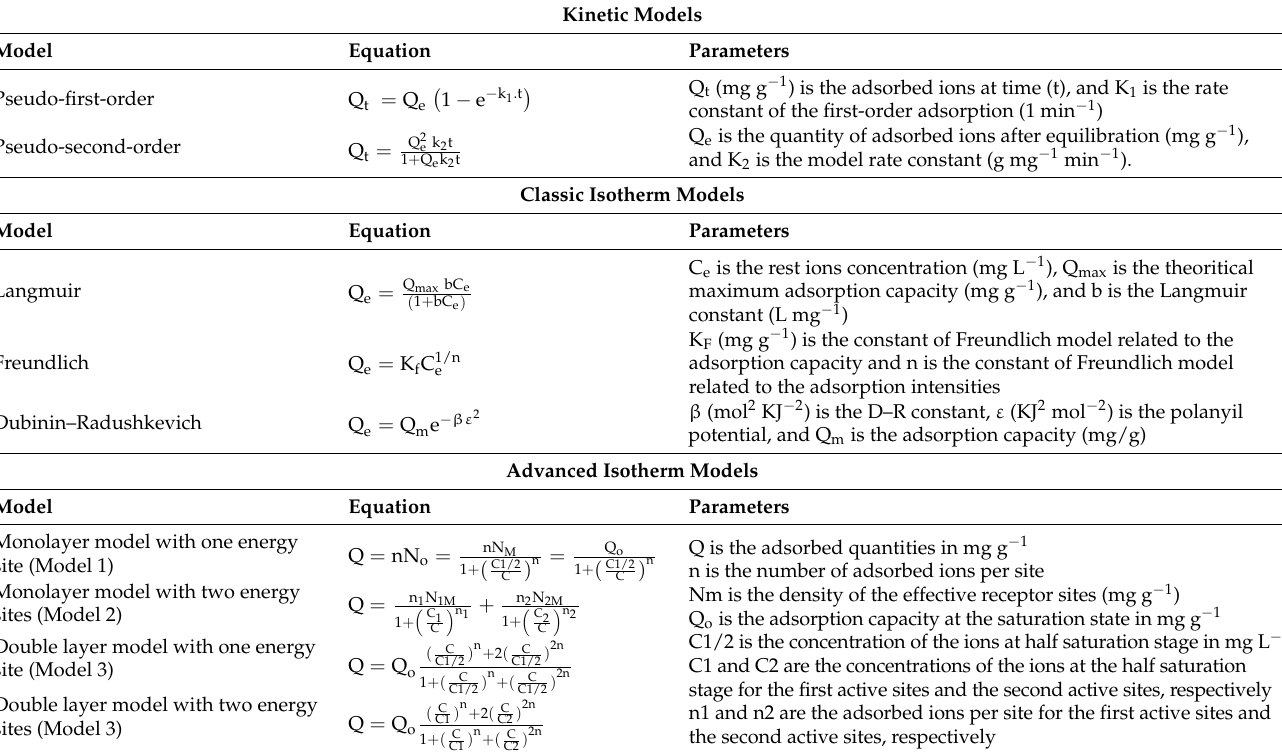
Table 1. Nonlinear equations of kinetic, classic isotherm, and advanced isotherm